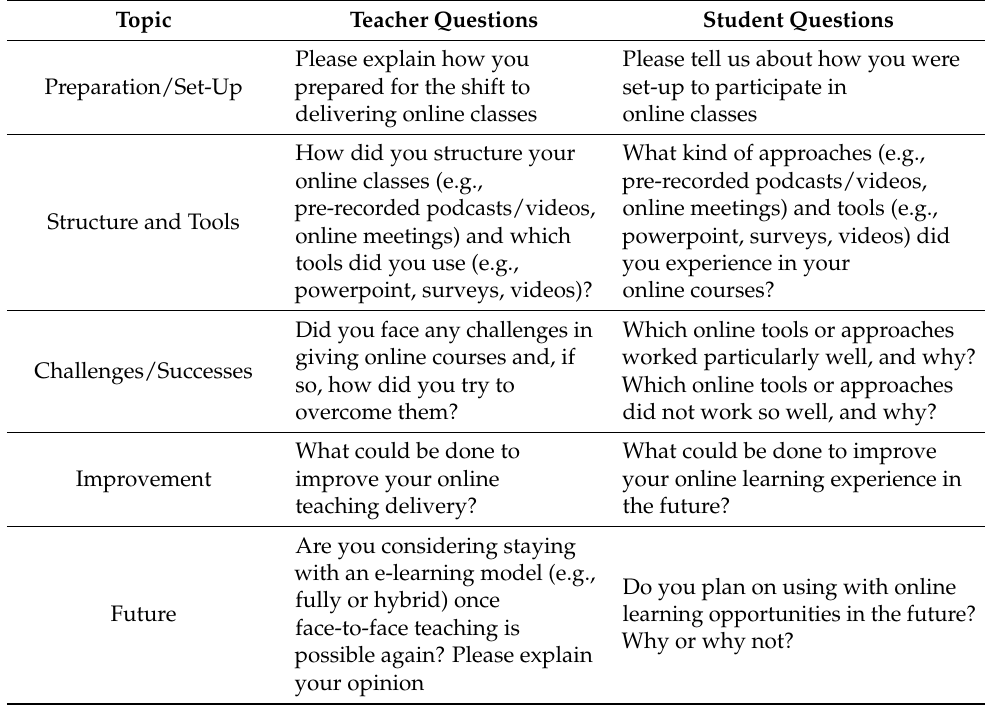
Table 1. Overview of qualitative survey